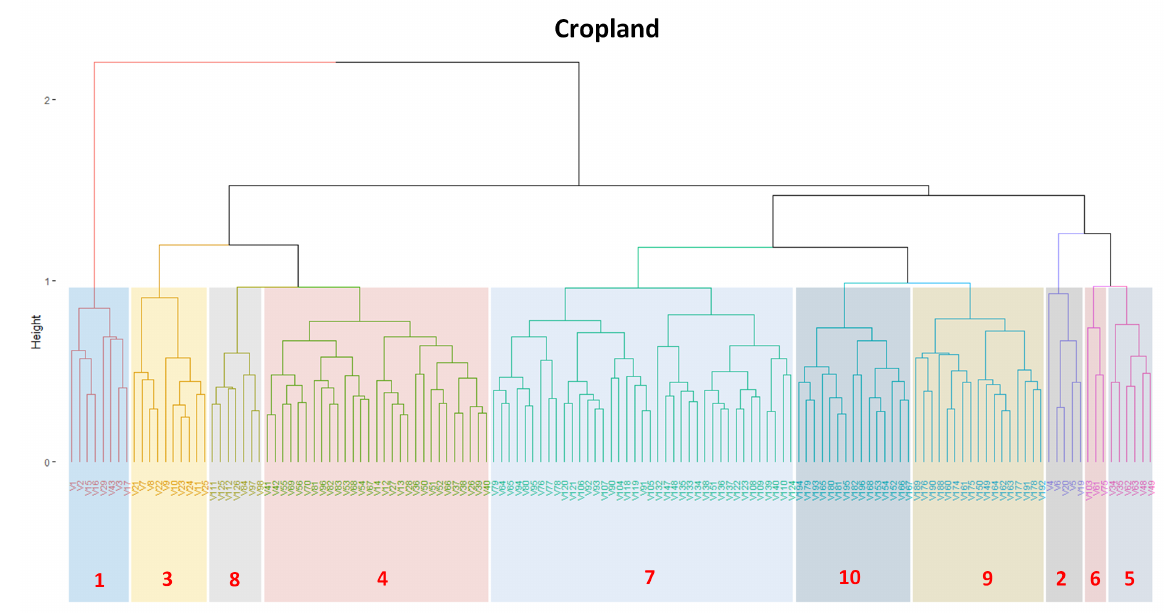
Figure 6. Dendrogram partitioned into ten groups for